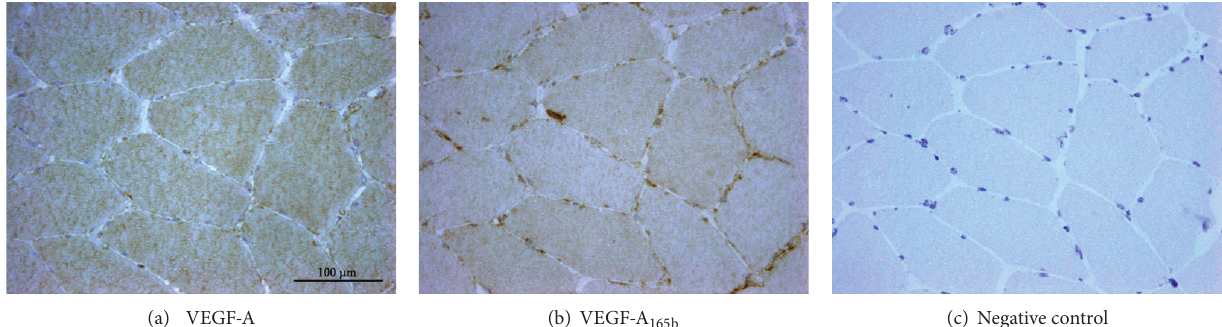
Figure 3: Immunohistological distribution of VEGF isoforms in control muscle. (a)–(c) Consecutive sections. Diffuse VEGF-A cytoplasmic reactivity, with stronger stain of endomysial sparse mononuclear cells stain of myofibers is observed (a); very mild cytoplasmic VEGF-A 165 b and endomysial small vessels (b). No stain on negative control slide by omission of primary antibody